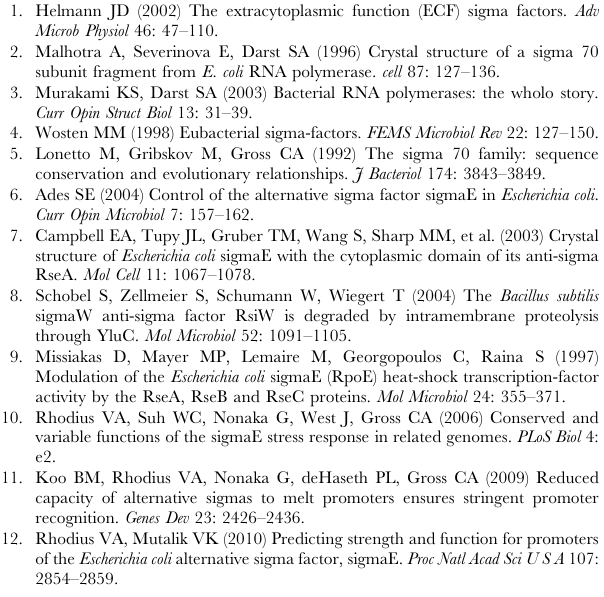
Table S1 Nucleotide sequences for electrophoretic mobility